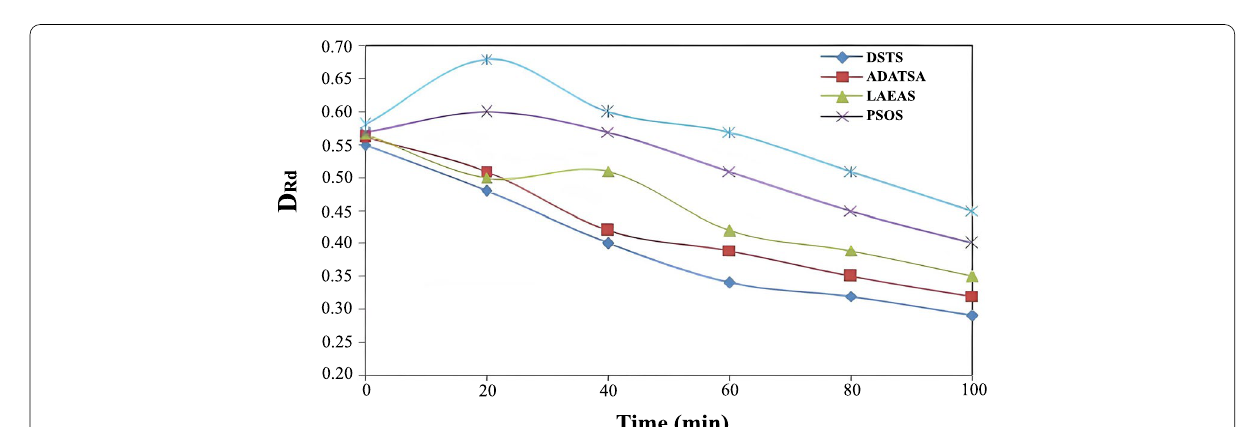
Fig. 9 Comparative analysis of resource residual degree (D Rd ) with time (Task-4)